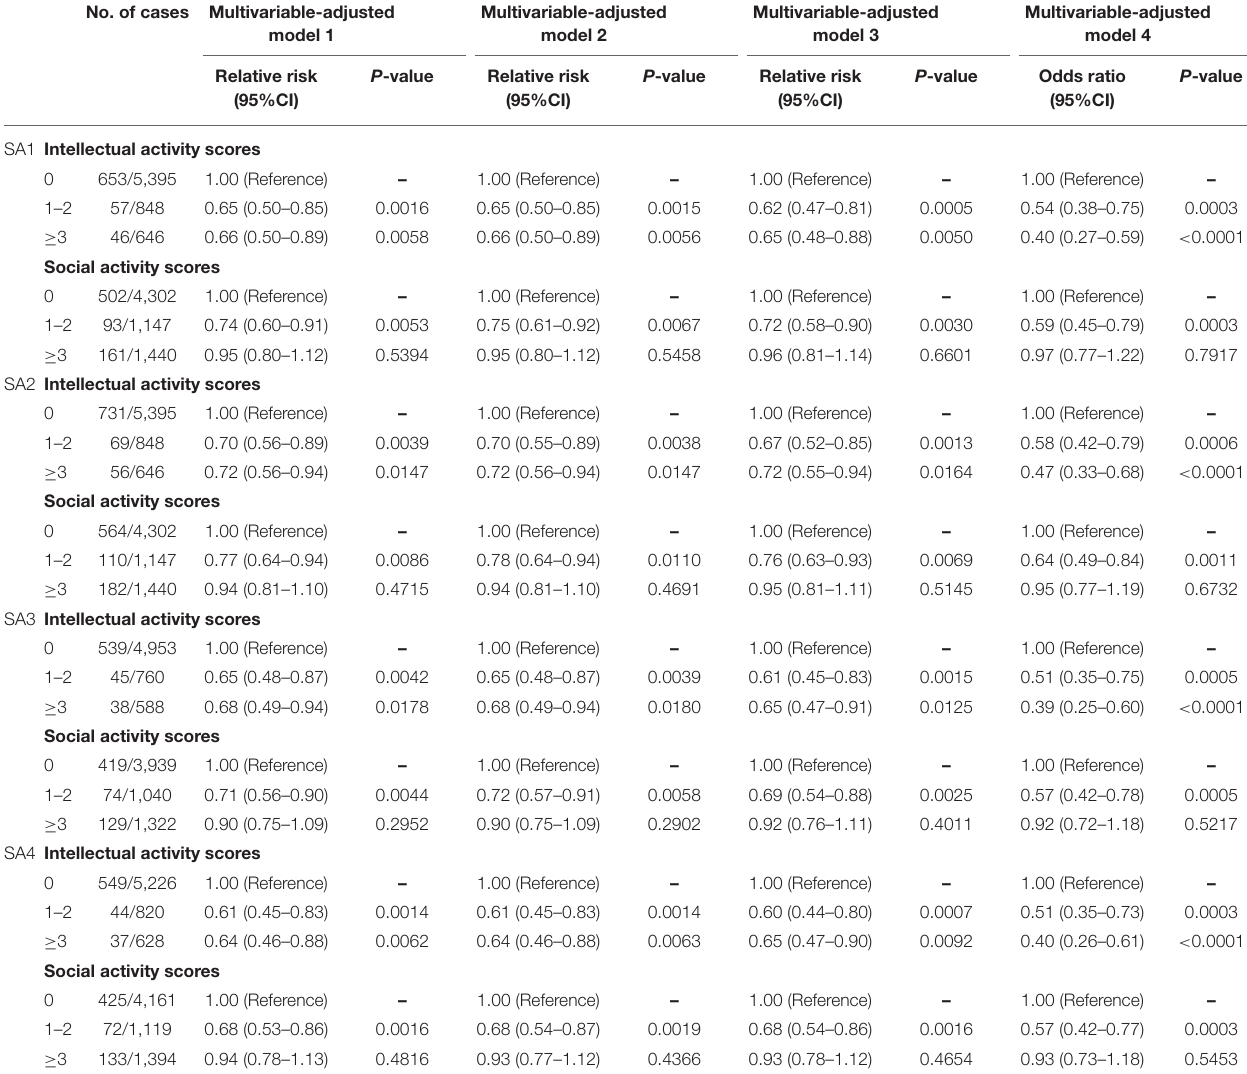
TABLE 4 | Sensitivity analyses: risk of frailty according to the intellectual activity and social activity scores. No. of cases Multivariable-adjusted model